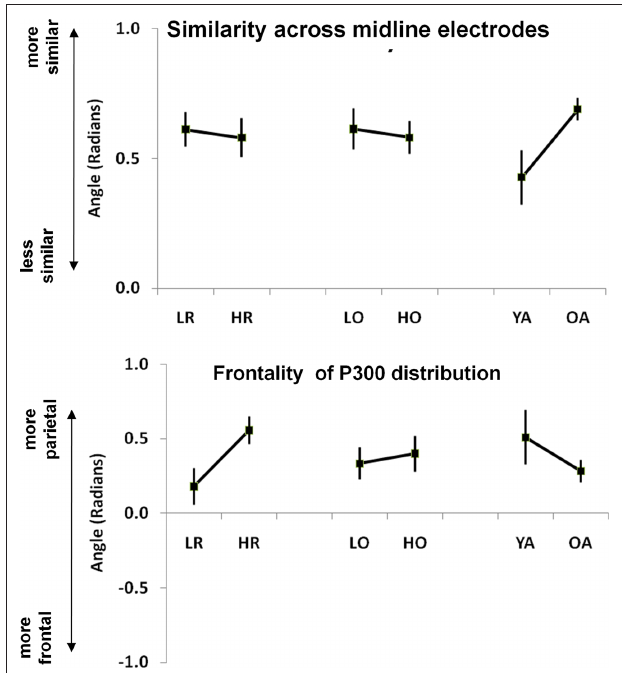
Figure 5 | effects of age, cognitive flexibility (rPM) and working memory capacity (OSPAN) on the similarity across midline electrodes (top) and on the relative frontality of the P300 distribution (bottom). Error bars refer to the SE of the mean. LR, low-RPM group; HR, high RPM group; LO, low OSPAN group; HO, high OSPAN group; YA, Younger adults; OA,